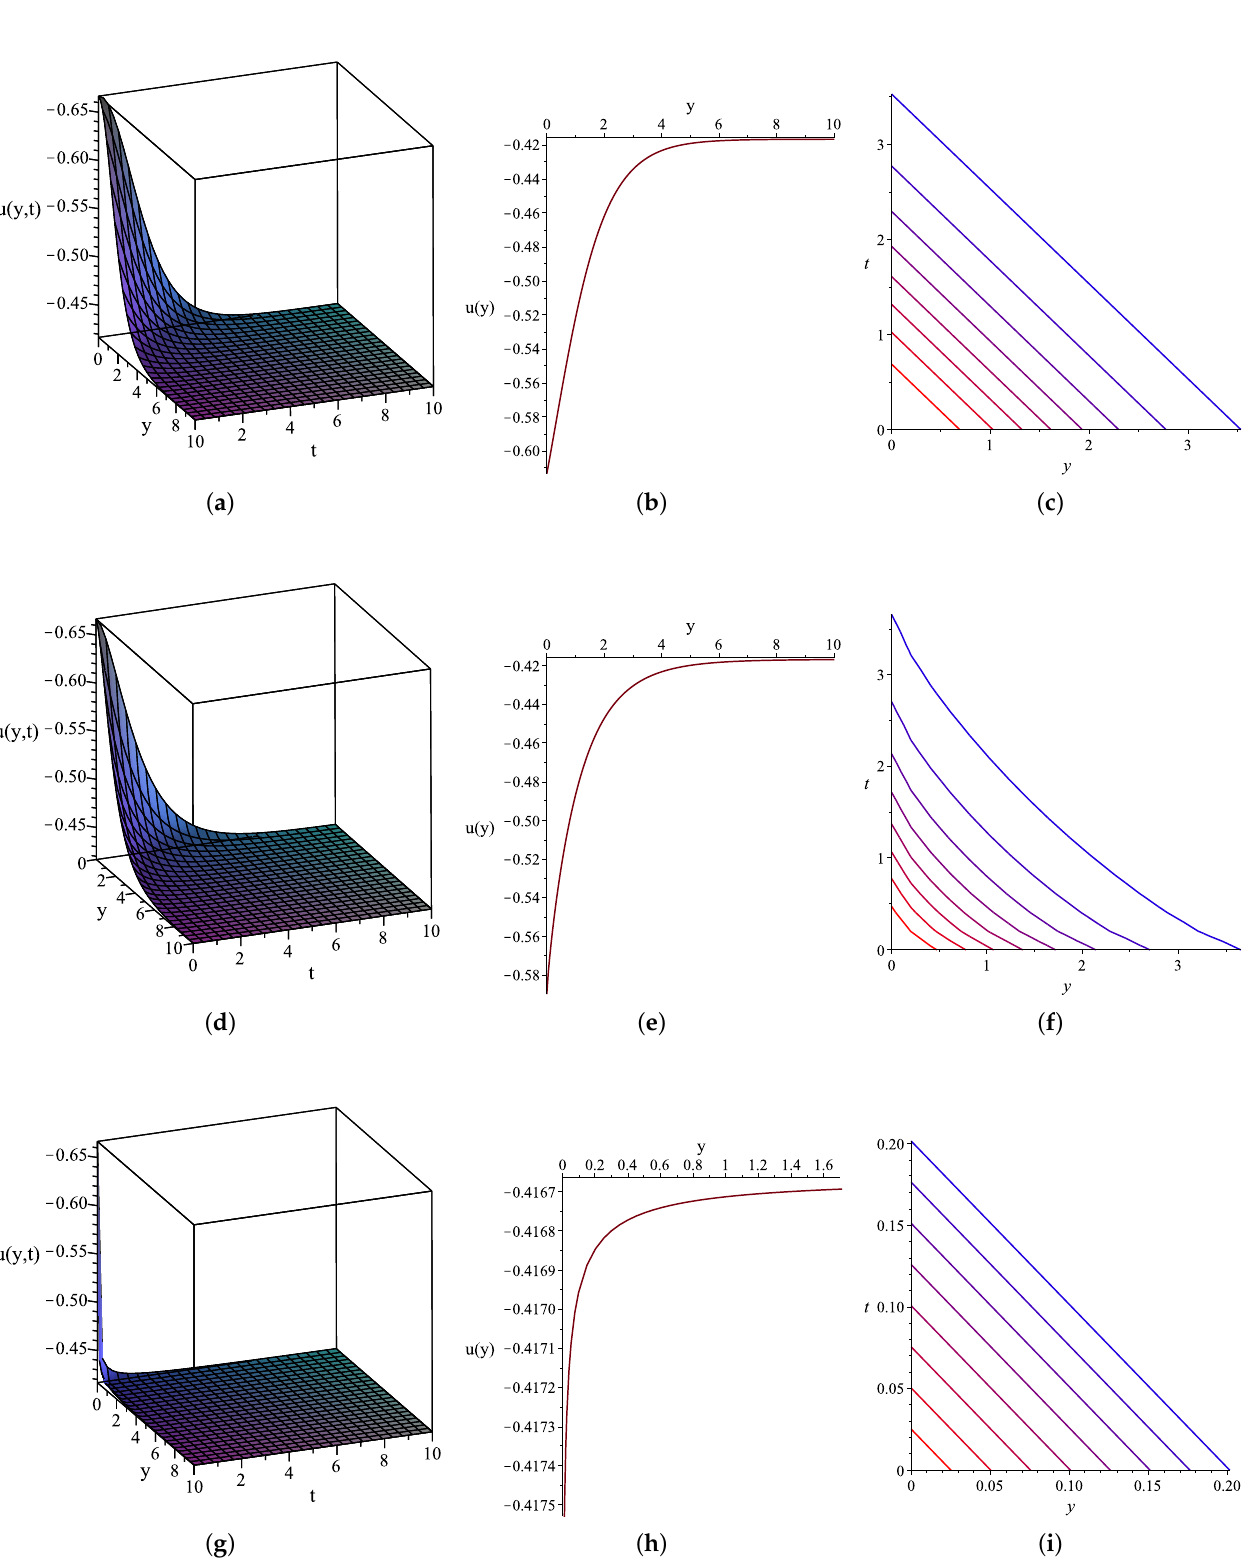
Figure 4. Associated plots of u 6 ( x , y , t ) in Equation (71) obtained using the auxiliary equation method: ( a – c ) 3-D plot, 2-D plot and contour plot, respectively when α = 1; ( d – f ) 3-D plot, 2-D plot and contour plot, respectively when α = 0.8; ( g – i ) 3-D plot, 2-D plot and contour plot, respectively when α =